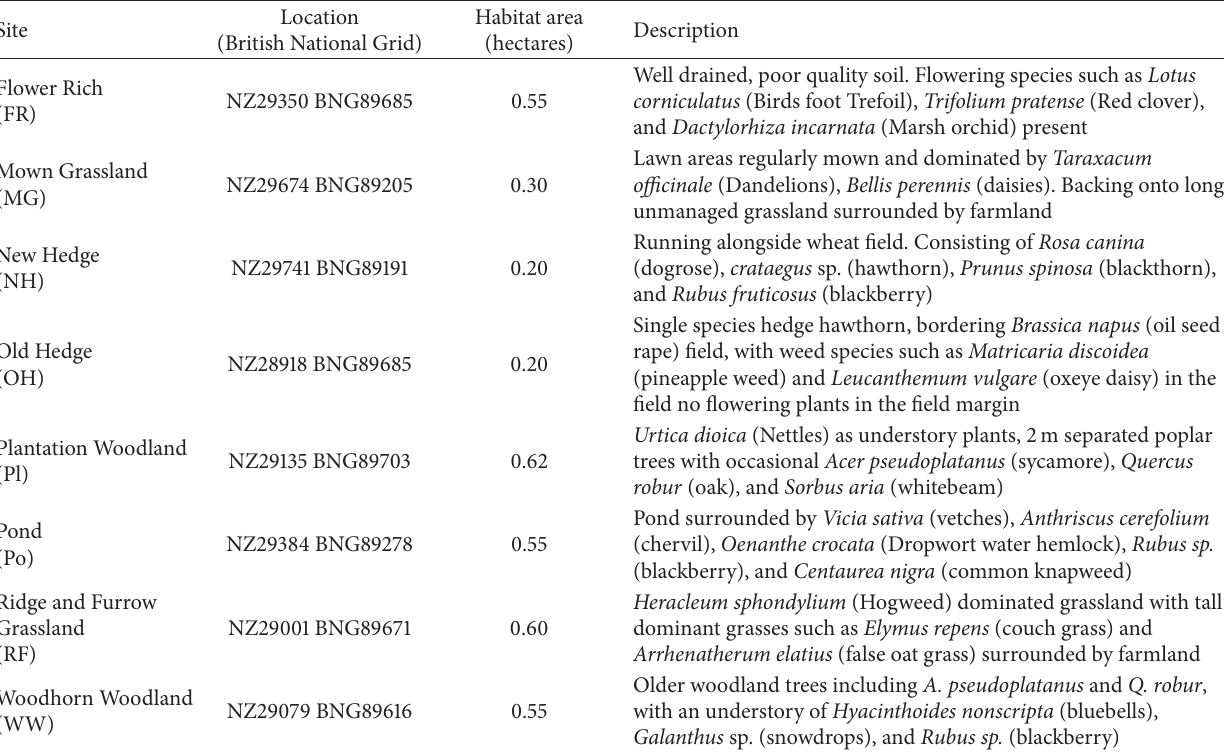
Table 1: Description of the eight sites used within the study, highlighting the name given, location, habitat type, and a description of the dominant plant species present within each